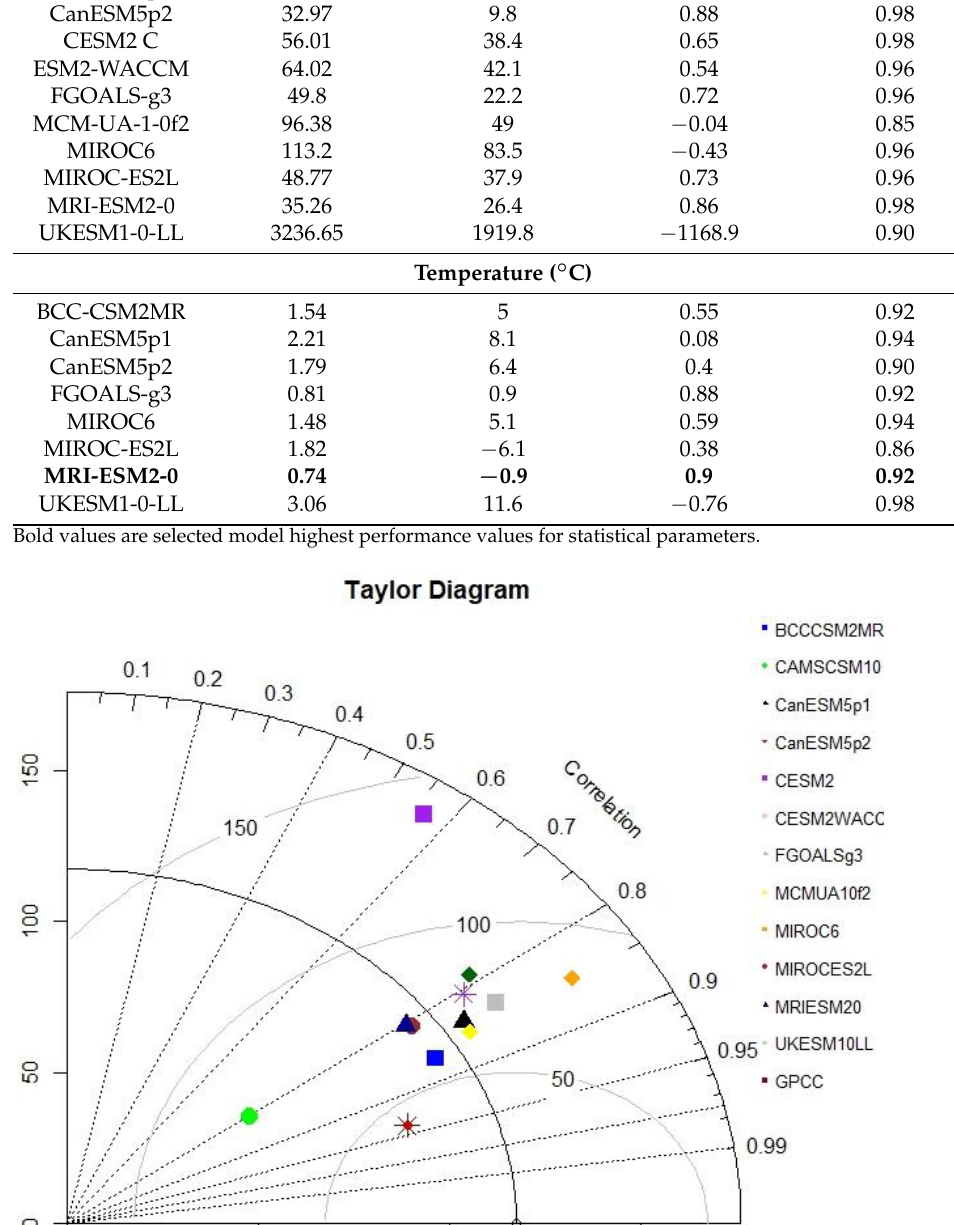
Figure 5. Taylor diagram comparing the temporal performances of twelve CMIP6 models precipitation (mm/day) against the ground-observed and GPCC reanalysis for the baseline period (1981 – 2010).